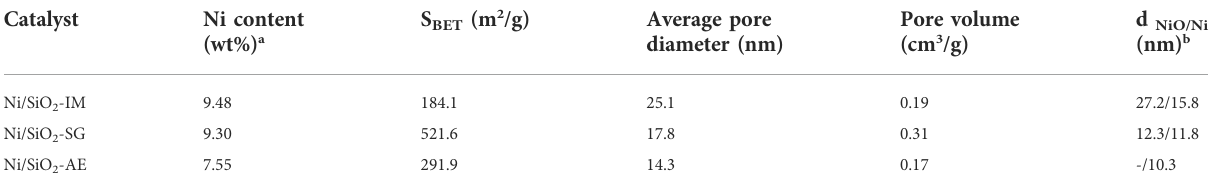
TABLE 1 Textural properties of Ni/SiO 2 catalysts.